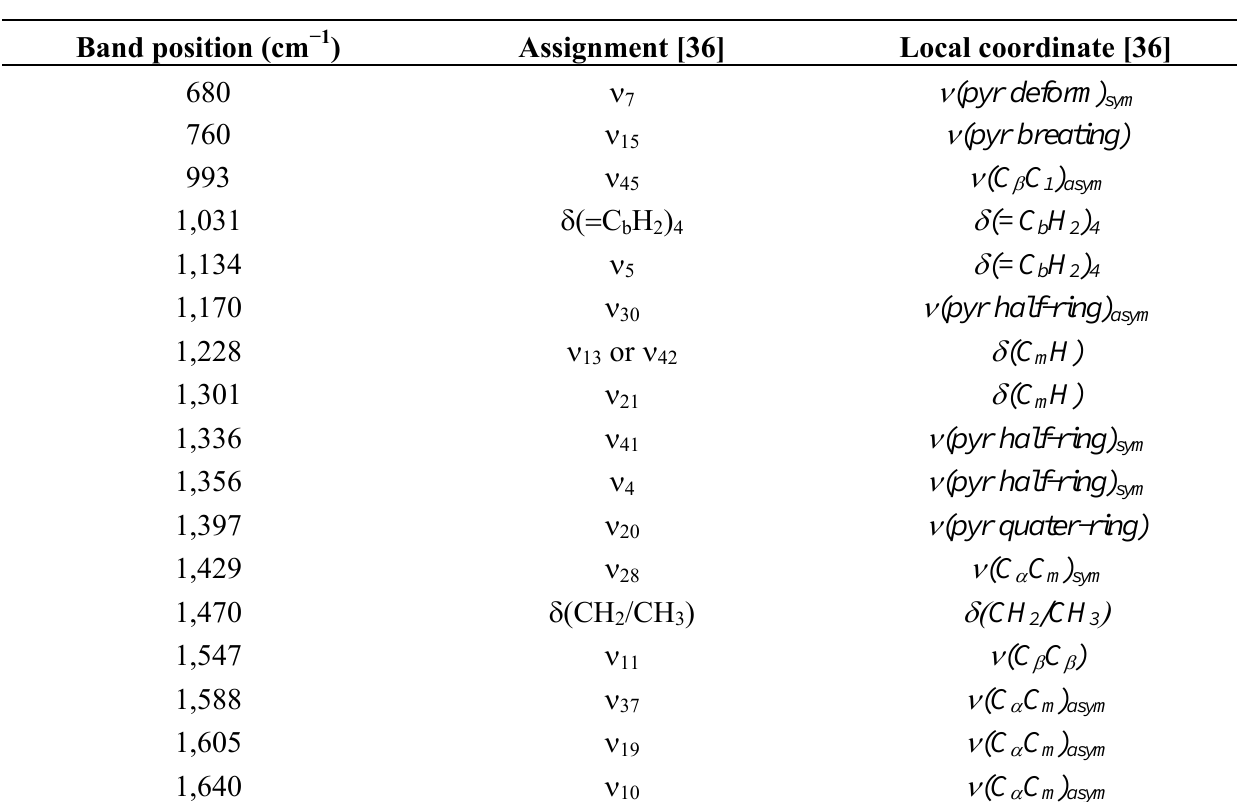
Table 1. Band position, assignment and local coordinate for normal RBCs recorded using a Raman excitation at 532